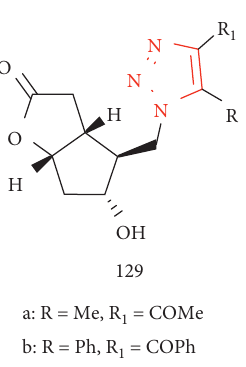
Figure 64: Chemical structure of 1 ′ -homo-N-1,2,3-triazole-bicyclic